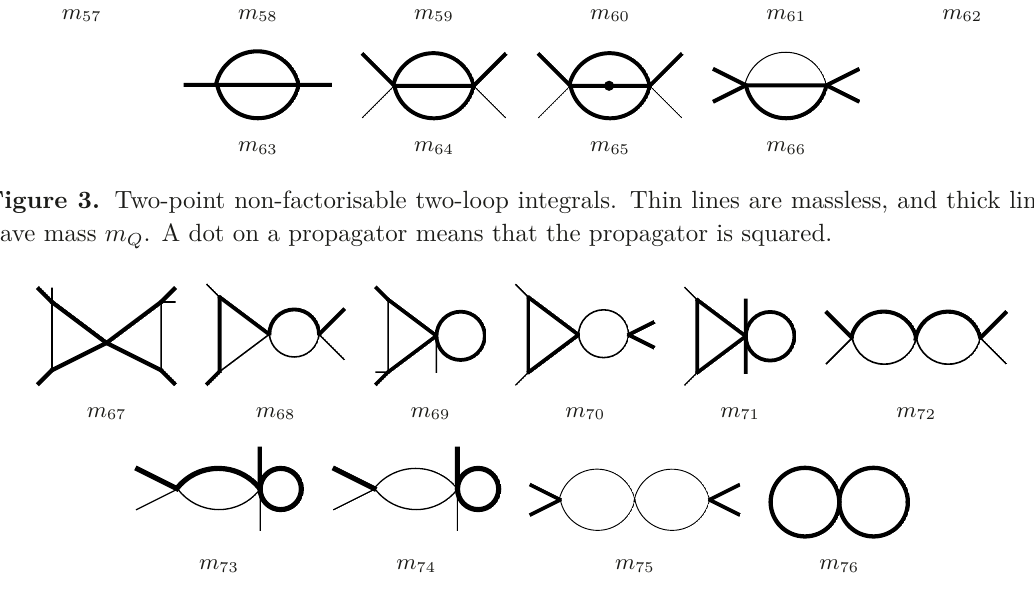
Figure 4. Factorisable two-loop integrals. Thin lines are massless, and thick lines have mass m Q